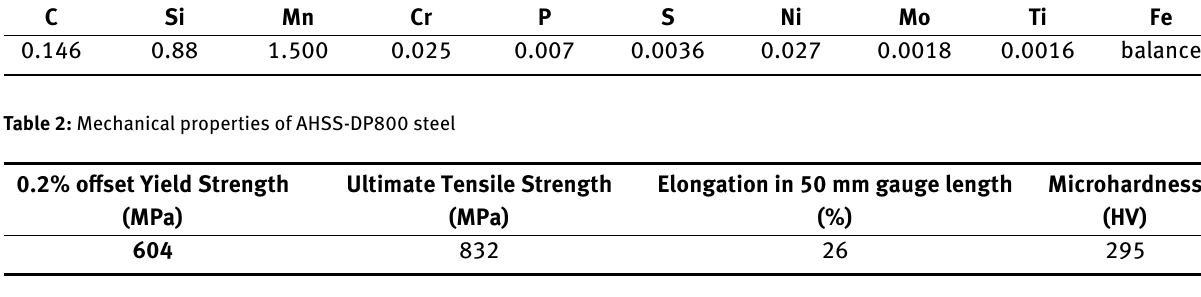
Table 3: Working limits of RSW parameters for joining AHSS-DP800 steel Parameter